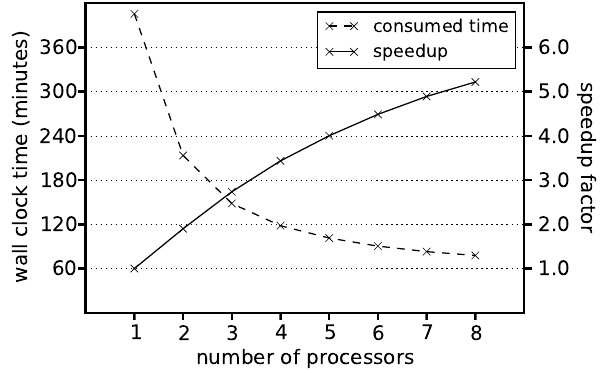
Fig. A1. Consumed wall clock time and achieved speedup factor for the baseline retrieval if an OpenMP parallelisation is